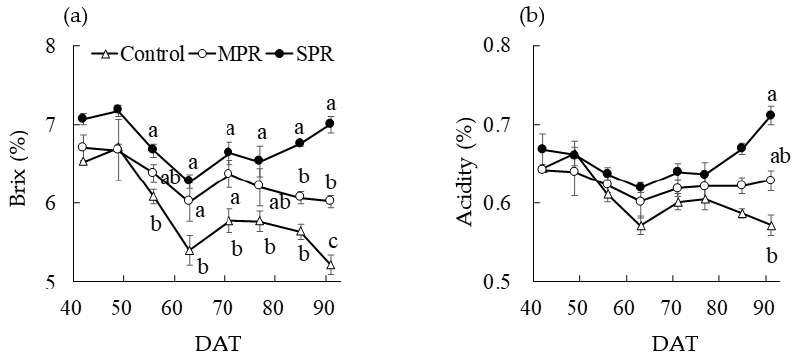
Figure 5. Effects of the days after the start of treatments (DAT) on the Brix ( a ) and acidity ( b ) of tomato fruits. Throughout the experiment, fruits were harvested eight times [42, 49, 56, 63, 71, 77, 85, and 91 days after the start of treatments (DAT)]. Error bars represent ± standard error. Different letters indicate significant differences among the treatments in each harvest based on the Tukey–Kramer’s test ( p < 0.05, n = 4–6). MPR: moderate wilting–partial recovery treatment. SPR: severe wilting–partial recovery